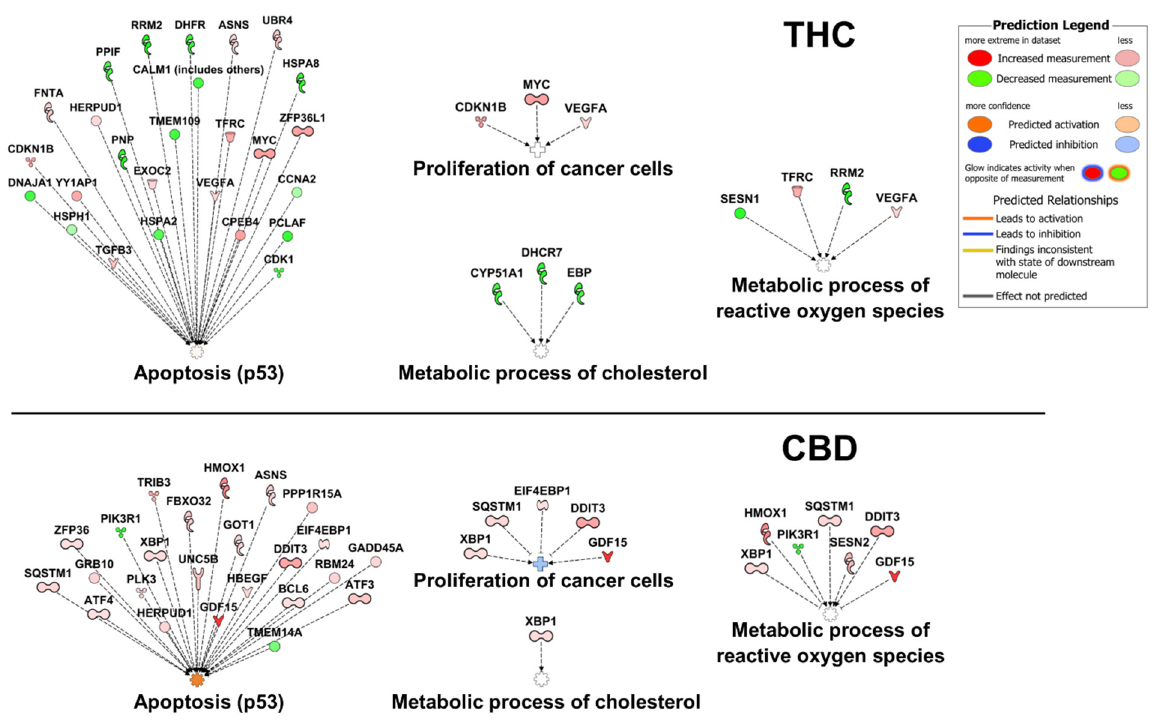
Figure 6. Pathway and function analysis of THC vs. CBD treatment induced differentially expressed genes in cancer. Differentially expressed genes in cancer cells treated with THC (Table S2) or CBD (Table S1) were analyzed for their contribution to common cellular functions in cancer using IPA (Qiagen). Genes identified by the IPA database as members of the “apoptosis”, “proliferation of cancer cells”, “metabolic process of cholesterol”, or “metabolic process of reactive oxygen species” pathways are shown for THC ( top ) and CBD ( bottom ).